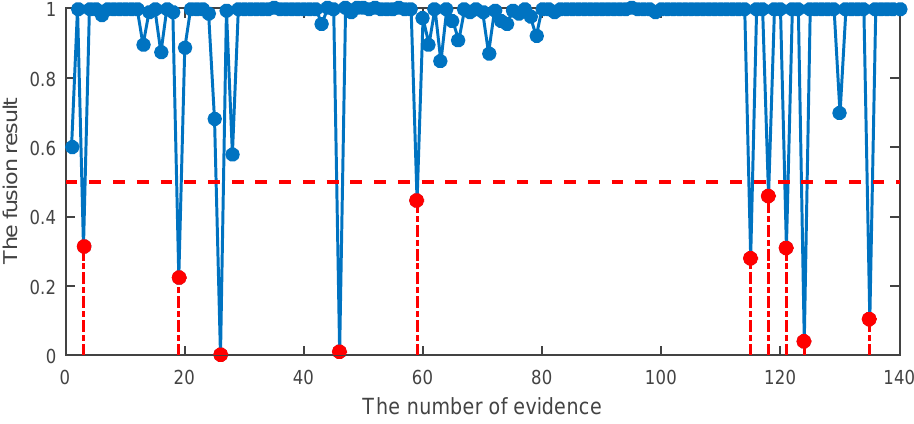
Figure 14. The fusion result using HCE with original DST.